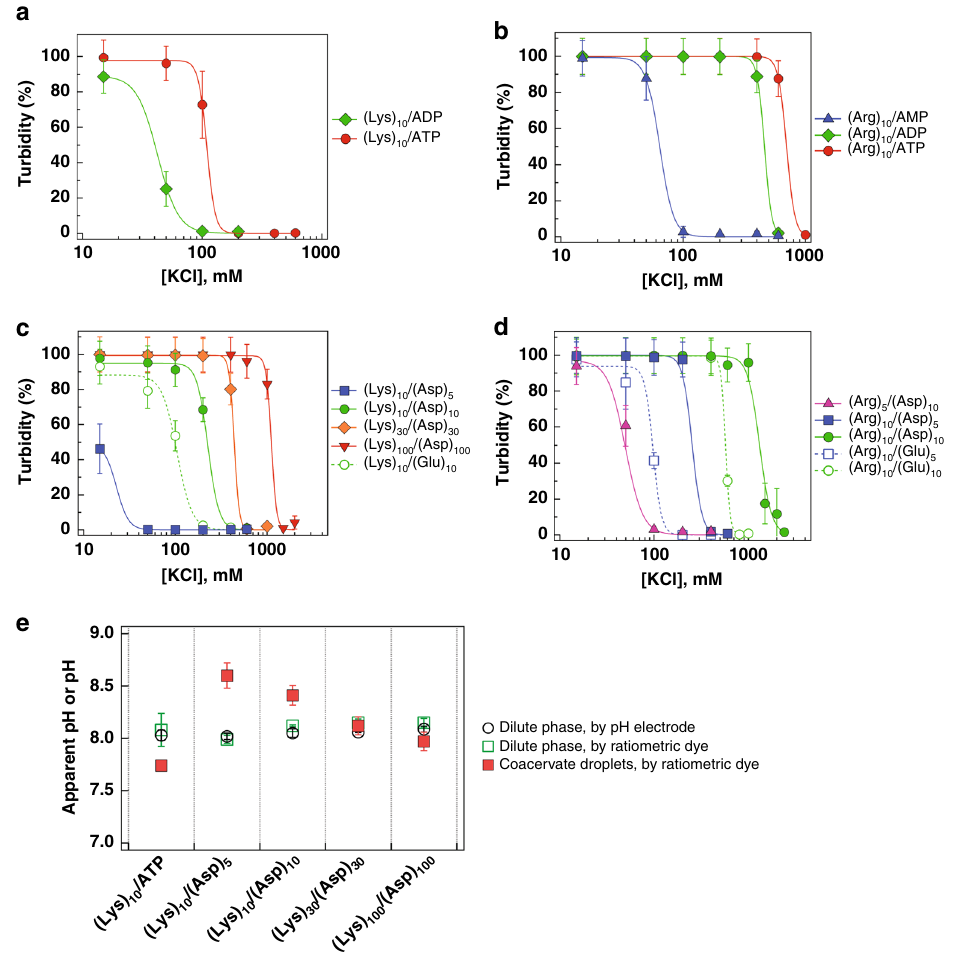
Fig. 3 Physical properties for selected coacervate systems as nucleotide charge and peptide length increase. a Salt resistance of coacervates formed from (Lys) 10 and nucleotides (ADP and ATP). b Salt resistance of coacervates formed from (Arg) 10 and nucleotides (AMP, ADP, and ATP). c Salt resistance of coacervates formed from Lys 10-100 as length of (Asp) n increases ( n = 5, 10, 30, and 100), and with Glu 10 . d Salt resistance of coacervates formed from (Arg) 10 and (Asp) 5,10 or (Glu) 5,10 . Critical salt concentrations determined from the fi ts for curves are available in Supplementary Table 1. Error bars show a – d standard deviation of measurements over at least three independent samples. Relative errors are minimally 10% turbidity values in panels a – d , and may not be visible on low turbidity values. See Supplementary Fig. 3 for individual trials of each experiment. e Measured (black circle) and calculated (green box) pH of the dilute phase, and calculated pH of coacervate droplets (red box) for different coacervate systems. See Supplementary Figs. 4 and 5 for calculations. Error bars show standard deviation of measurements over at least three independent